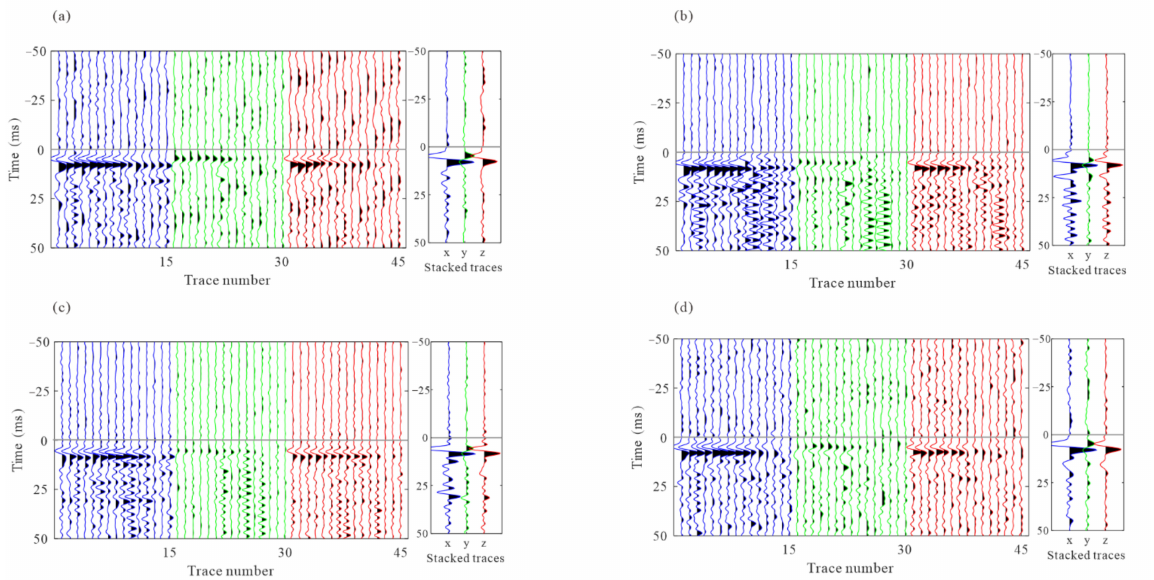
Figure 14. The 3C recording of the example events after residual time correction based on corrected P-wave arrival picks and the stacked waveforms on their right. ( a – d ) are P-wave recordings from the four events in Figure 10. The gray horizontal lines represent the corrected arrival picks of the P-wave. Blue, green, and red lines represent x-, y-, and z- components, respectively.